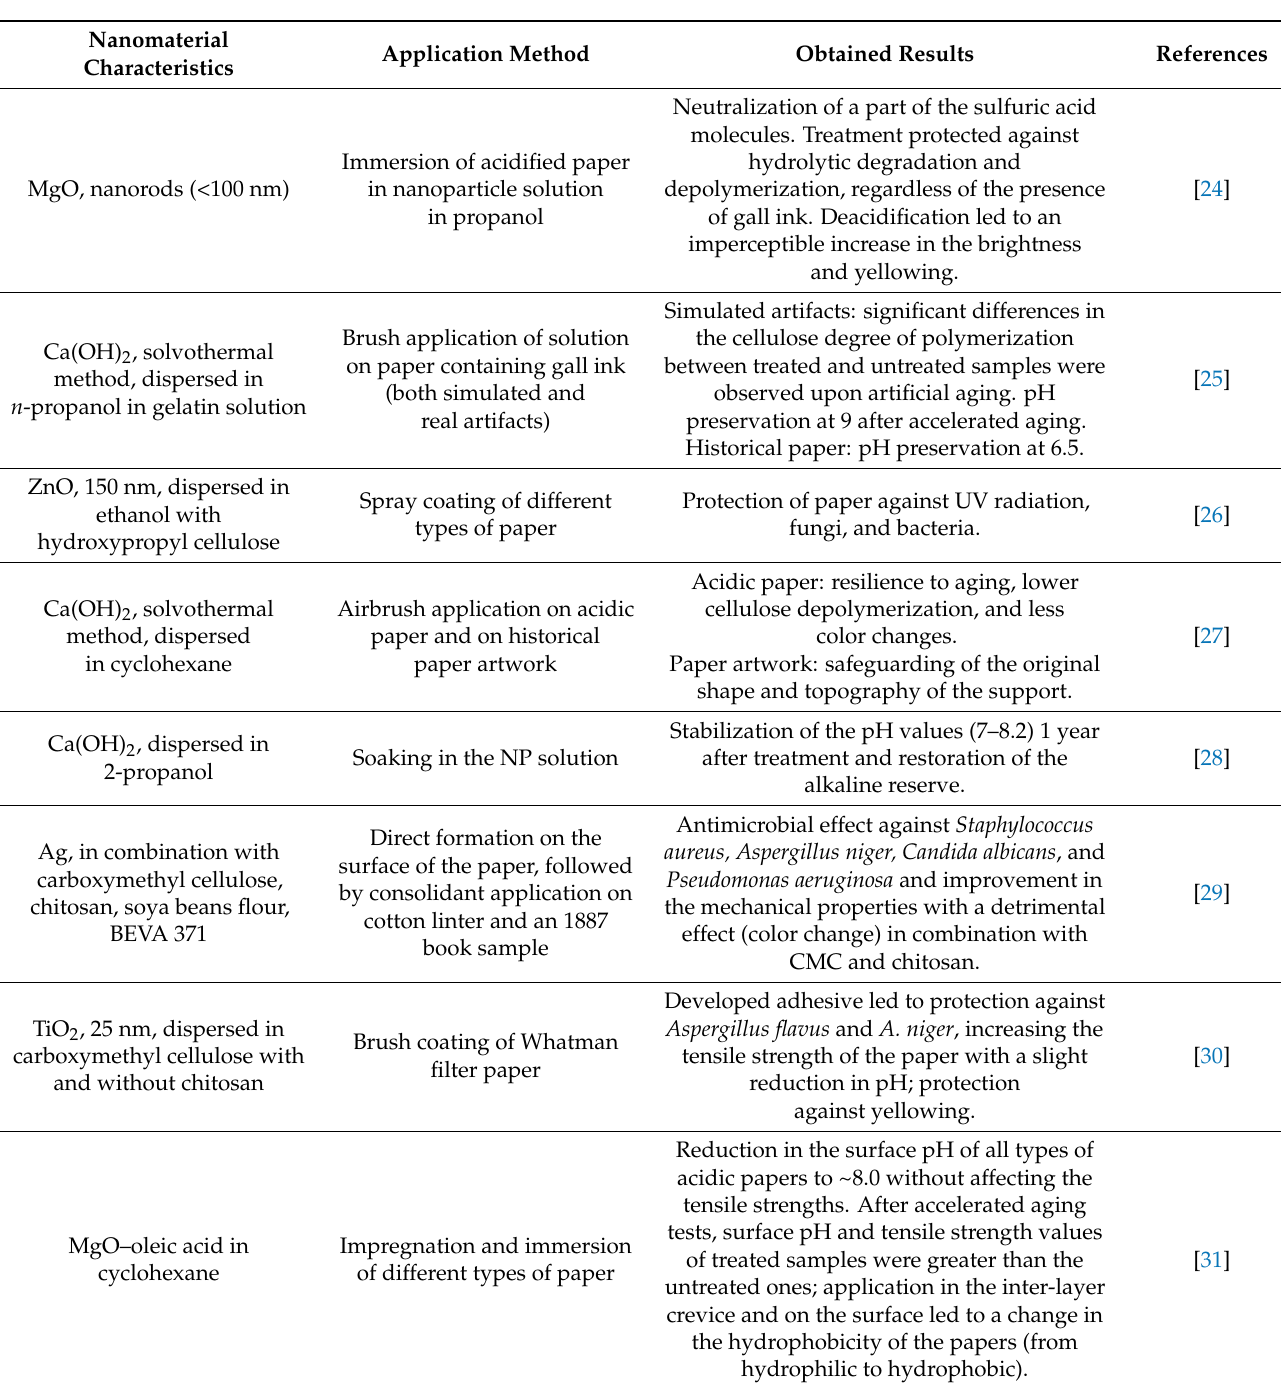
Table 1. Application of inorganic nanomaterials for the treatment of historical paper artifacts (refer- ences presented in chronological